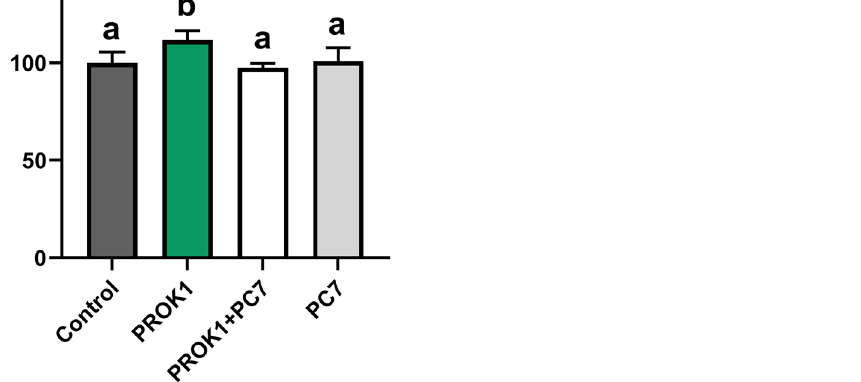
Figure 4. The viability of luteal explants after in vitro treatment analyzed by Alamar Blue assay. Precision- cut luteal slices were incubated with control (vehicle) or PROK1 (40 mM) for 18 h in the presence/absence of prokineticin receptor 1 (PROKR1) antagonist (PC7; 10 µM). Data are presented as means of the fold change versus control (100%) ± SEM. Different lowercase letters (a, b) indicate statistical significant differences between treatments.